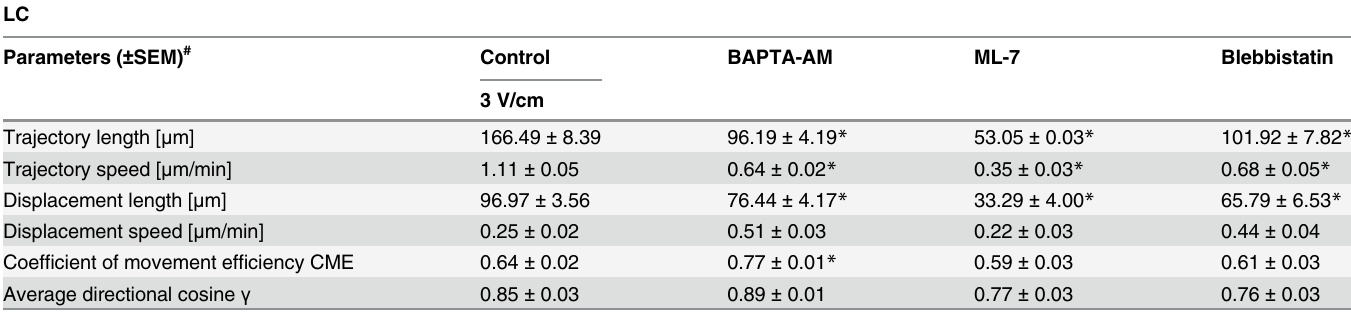
Table 7. Quantitative data showing the effects of BAPTA, blebbistatin and ML-7 on the electrotaxis of LC